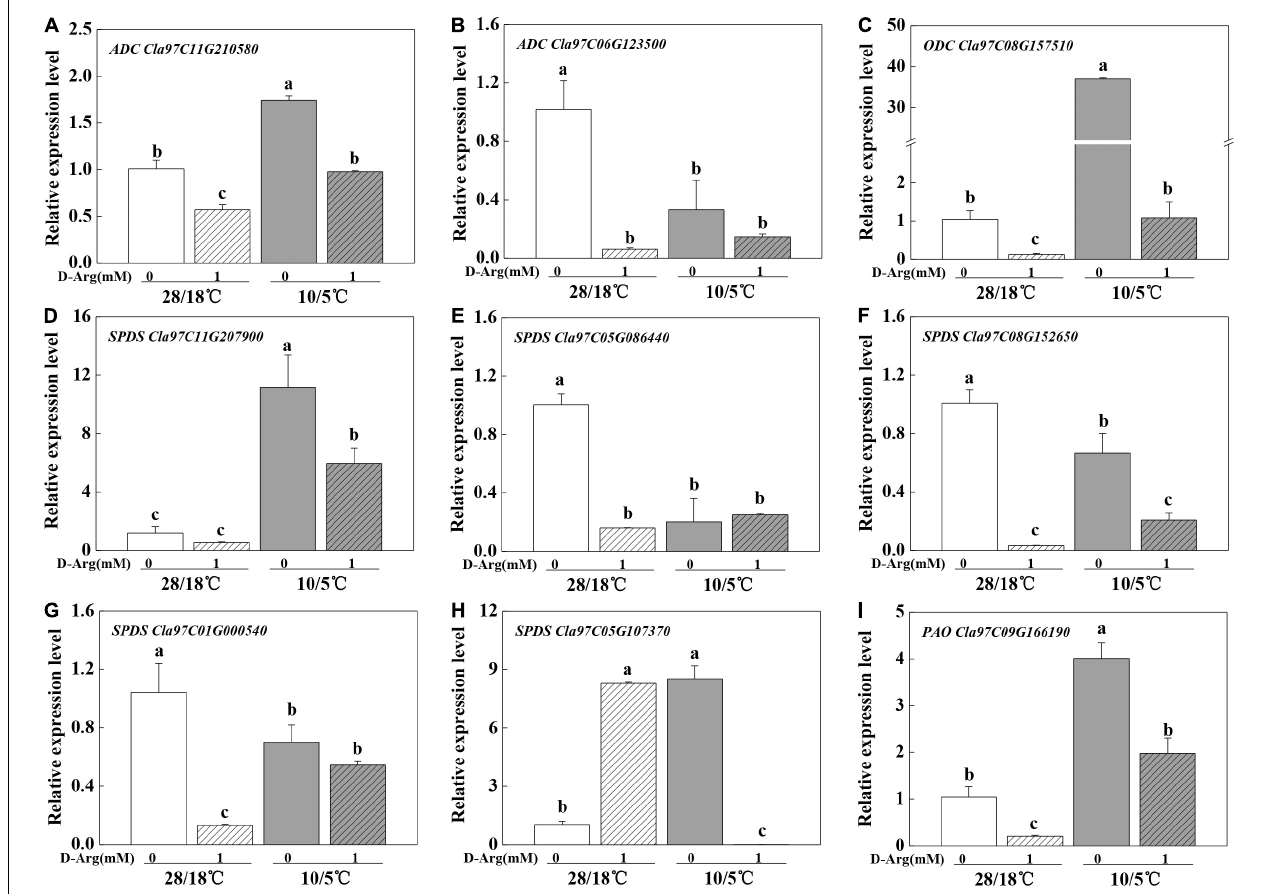
FIGURE 4 | Effects of inhibition of putrescine synthesis on the expression of key genes in polyamine synthesis and metabolism in Cl/Cm plants. (A) ADC, Cla97C11G210580. (B) ADC, Cla97C06G123500 . (C) ODC, Cla97C08G157510 . (D) SPDS, Cla97C11G207900 . (E) SPDS, Cla97C05G086440 . (F) SPDS,